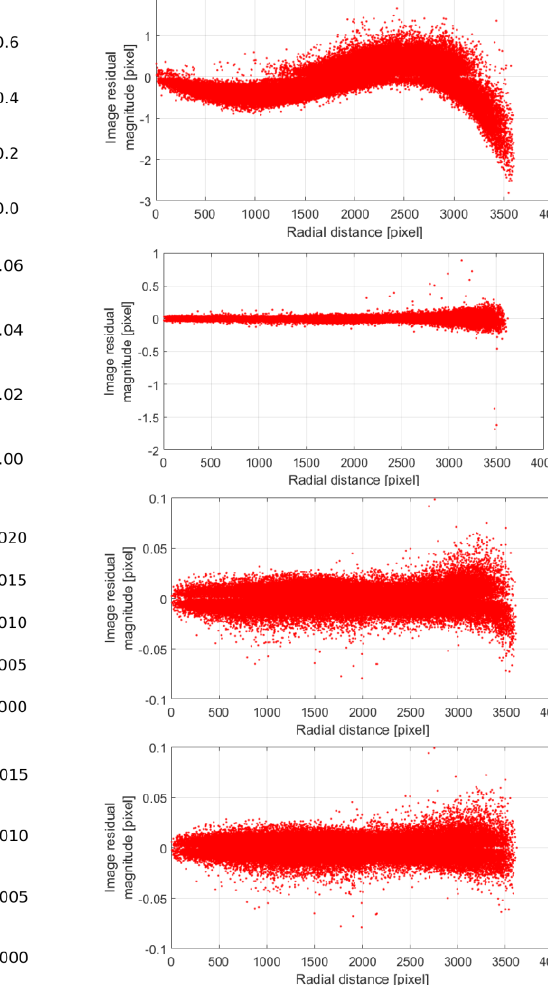
Figure 6. Image residuals for the dataset DP+30 SINGLE ROUND TRIP STRIP before (a,c) and after (b,d) applying the developed method. In (a) only k1 is computed in the bundle adjustment; (b) shows the results after further applying 10 iterations to (a) with the proposed method. Full radial distortion parameters k1, k2, k3 are computed in the bundle adjustment (c); (d) shows the results after further applying 1 iteration to (c) with the proposed method.